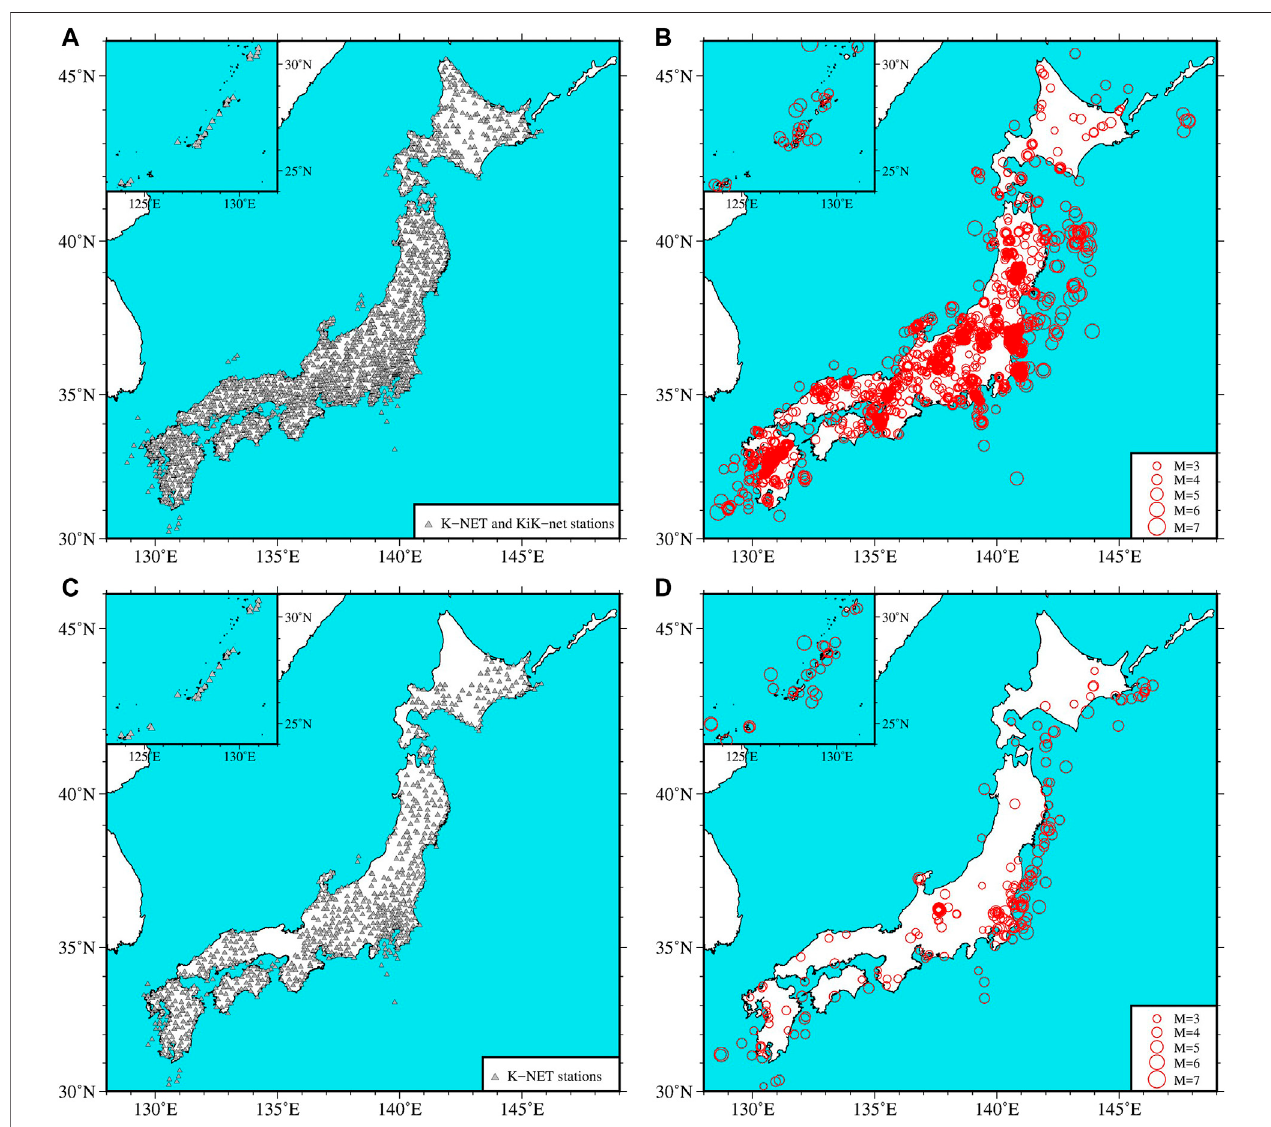
FIGURE2|(A) Locationsofthestations inthetraining setinthisstudy. (B) Locations oftheepicenters (open circles,sizeinproportion tomagnitude)inthetraining set. (C) Locations of the stations in the testing set. (D) Locations of the epicenters in the testing set.